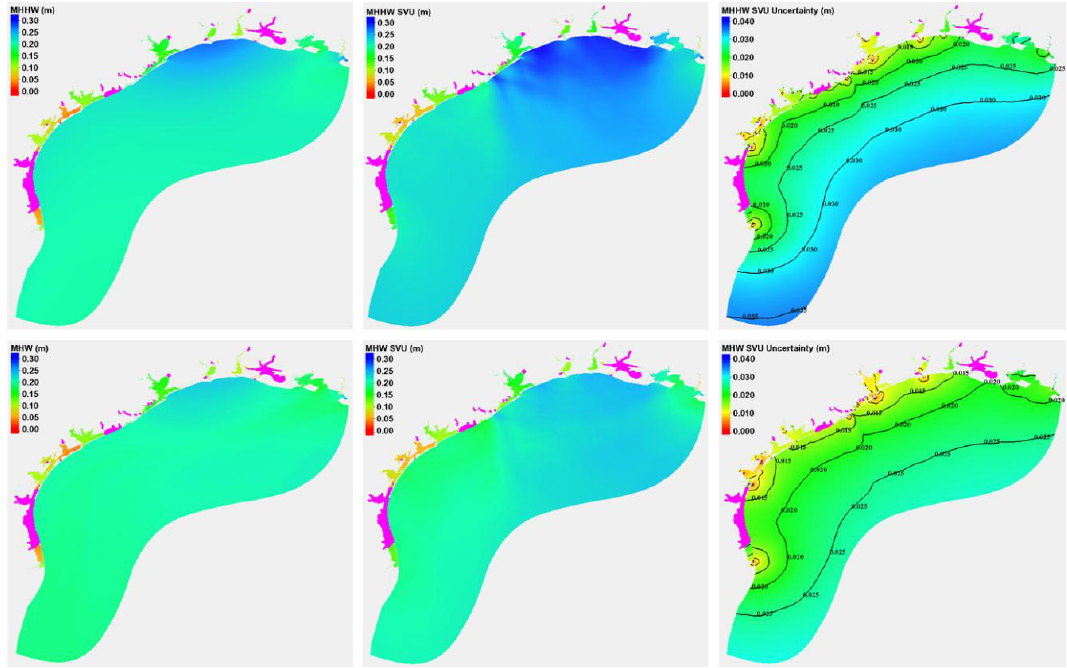
Figure 9. Modeled MHHW ( upper row ) and MHW ( lower row ) tidal datums. The first column shows ADCIRC modeled tidal datums; the second column shows the tidal datums after the SVU statistical interpolation; the third column shows the associated SVU spatially varying uncertainties. Model grid points in pink represent the modeled non-tidal grid points (modeled MHW-MLW < 0.09 m).